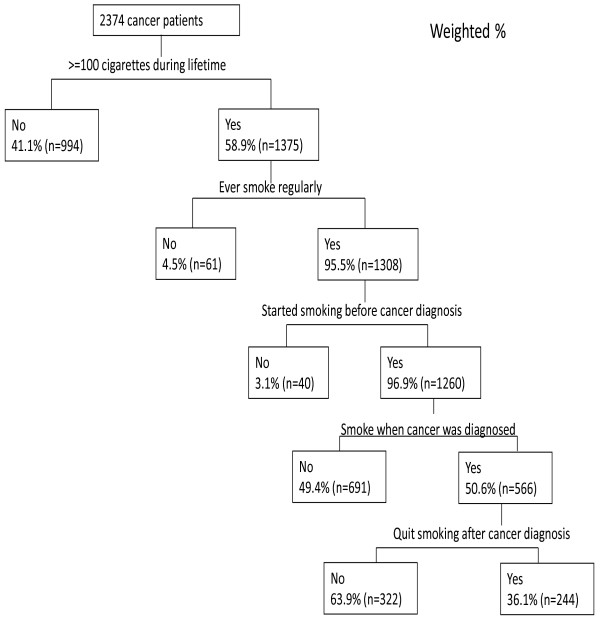
Diagram of data analysis from NHANES 99-08.